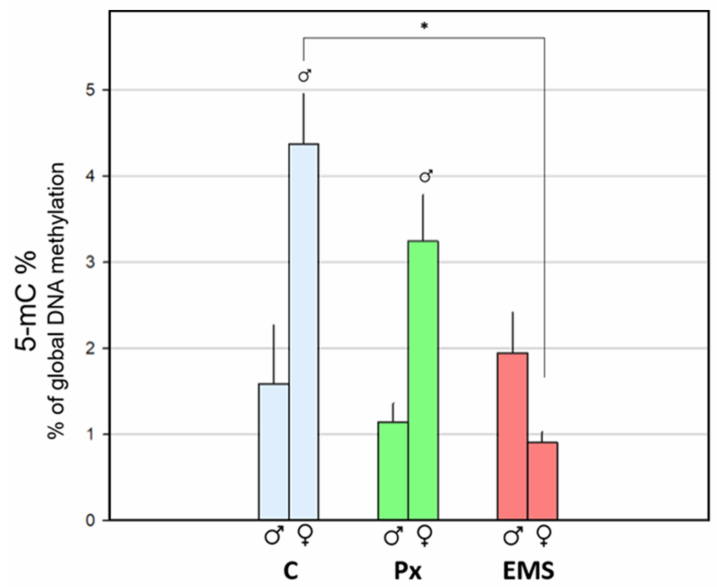
Figure 1. Schematic representation of the experimental design, depicting an intergenerational trial involving the exposure of the red swamp crayfish ( Procambarus clarkii ) to the genotoxicants penox- sulam (Px; green line) and ethyl methanesulfonate (EMS; red line). Sub-trial 1: exposure (7 days) of male ( ) and female ( ) adults, from F 0 , to Px and EMS, in comparison with a control group (blue line). After reproduction of the F 0 organisms (intragroup crosses), F 1 offspring were divided into two sub-trials (2.1 and 2.2). Sub-trial 2.1: the progeny (F 1 ) of each F 0 group was allowed to grow in uncontaminated water until adulthood (blue line); global DNA methylation was analyzed in both stages (juvenile and adult). Sub-trial 2.2: the progeny (F 1 ) of each F 0 group was allowed to grow in uncontaminated water only until the juvenile stage and then exposed to Px and EMS for 7 days, and thereafter analyzed in comparison with a control group. represents the sampling moments.